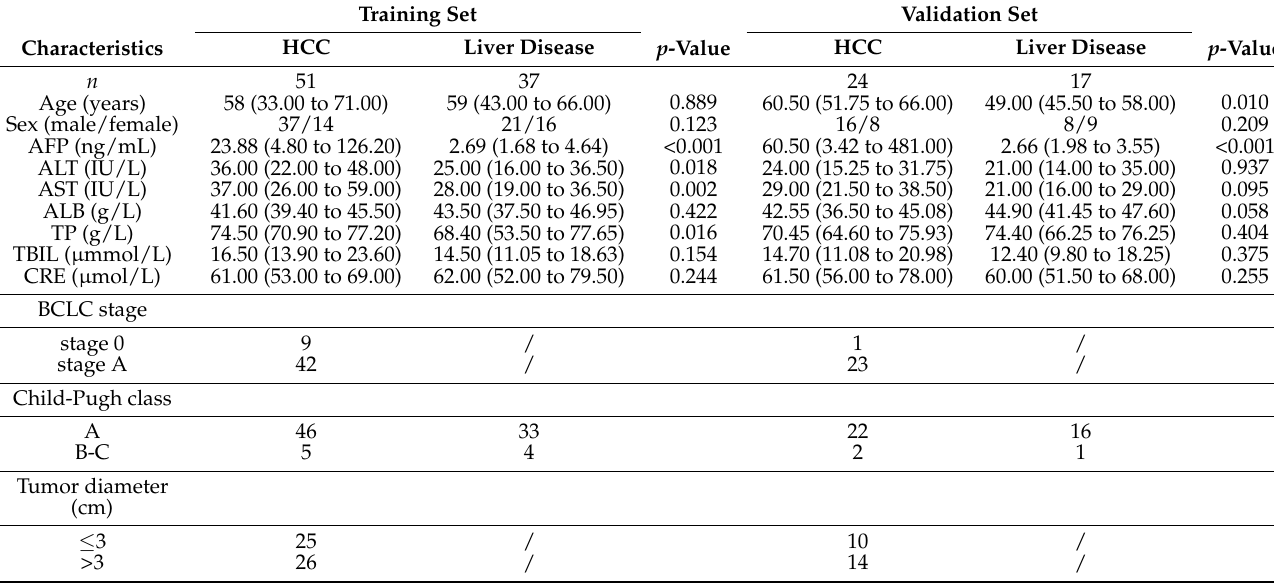
Table 1. Clinical characteristics of the HCC group and LD